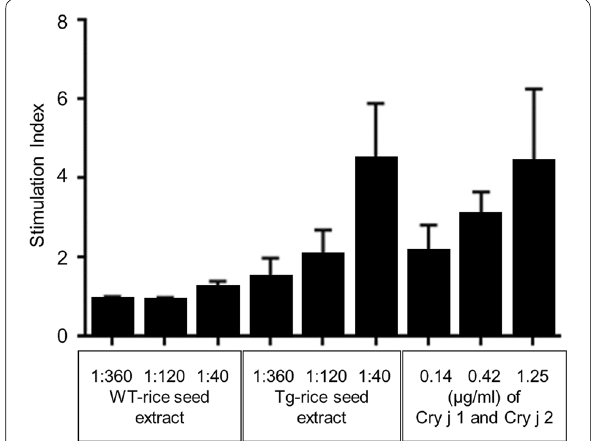
Fig. 1 Allergen-specific lymphocyte stimulation test to determine the allergen concentration in the basophil activation test. Several dilutions of WT- or Tg-rice seed extract, and Cry j 1 and Cry j 2 were added to PBMCs separated from blood samples from the first three patients with JC pollinosis. Allergen-specific lymphocyte proliferative responses to those allergens were determined using an in vitro 3 H-thymidine incorporation assay. The proliferation of allergen-specific lymphocytes following stimulation with 1:40 dilution of Tg-rice seed extract was almost equivalent to the proliferation following stimulation with the mixture consisting of Cry j 1 and Cry j 2 (both at 1.25 Values represent n (%) or mean SD (min.–max.) ±